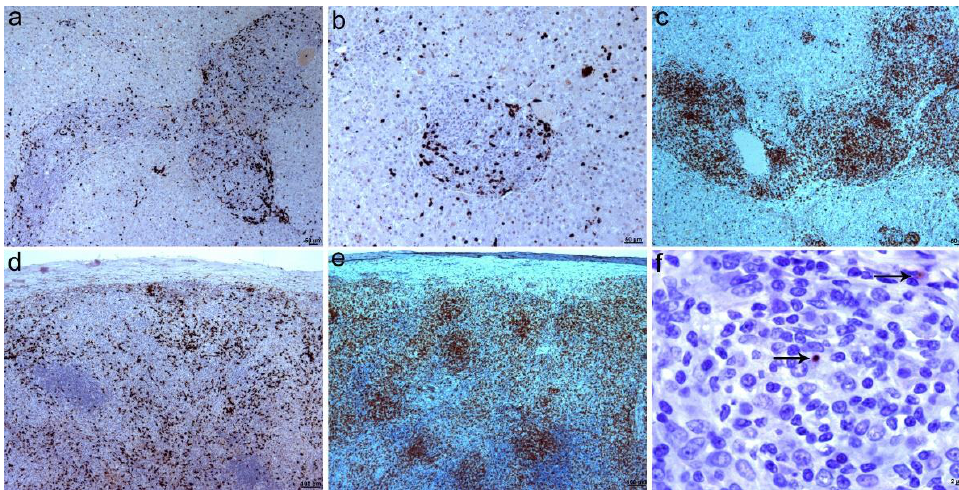
Figure 6. Immunohistochemical findings in dog 2. ( a ) Numerous macrophages infiltrate mainly portal areas and spread through the parenchyma bridging the portal areas (polyclonal antibody against MAC387 antigen), 200×. ( b ) Detail of macrophages forming a granuloma and scattered throughout the parenchyma (polyclonal antibody against MAC387 antigen), 400×. ( c ) Numerous T lymphocytes infiltrating portal areas and spread through the parenchyma bridging the portal areas (polyclonal antibody against CD3), 50×. ( d ) Granulomatous splenitis with numerous macrophages near the capsule (polyclonal antibody against CD3), 100×. ( e ) Granulomatous splenitis with numerous T lymphocytes forming aggregates near the capsule (polyclonal antibody against CD3), 100×. ( f ) Scattered amastigotes in the spleen, associated with macrophages not organized in granulomas. Arrows mark brown immunostained parasites (polyclonal antibody against Leishmania ), 630×.